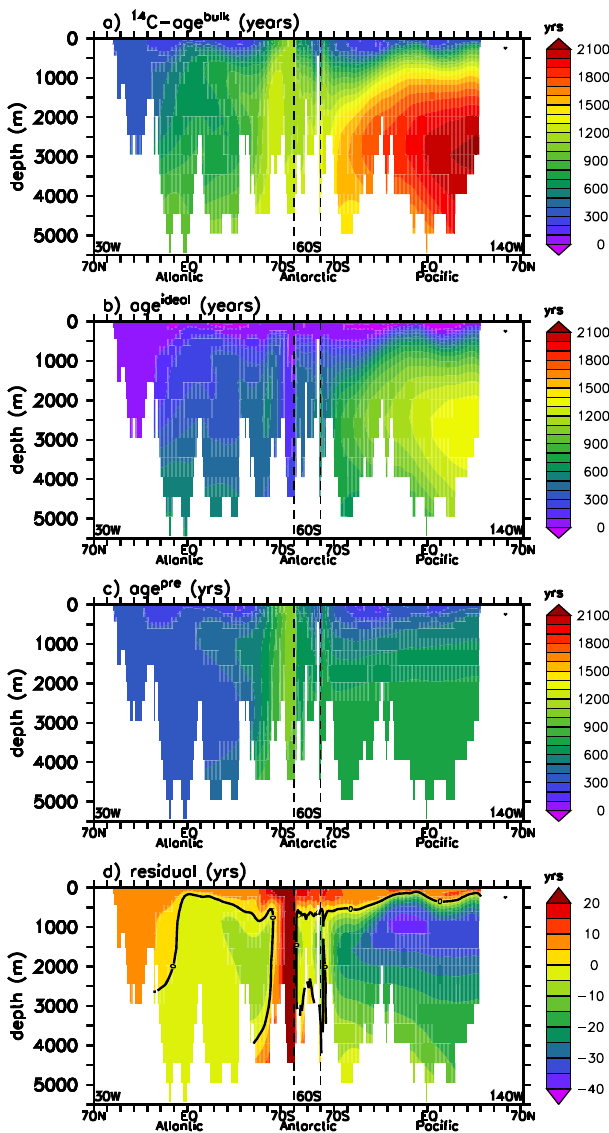
Figure 3. Bulk 14 C-age (a) , ideal age (b) and preformed age (c) from the ECCO experiment along a combined section through the North Atlantic (30 ◦ W), the Southern Ocean (60 ◦ S), and the Pacific Ocean (140 ◦ W). The preformed age is taken from the age pre tracer (see Sect. 2.2 for tracer definition). Panel (d) shows the residual ( 14 C-age bulk − age ideal − age pre ), i.e. the third term on the right- hand side of Eq. (4).